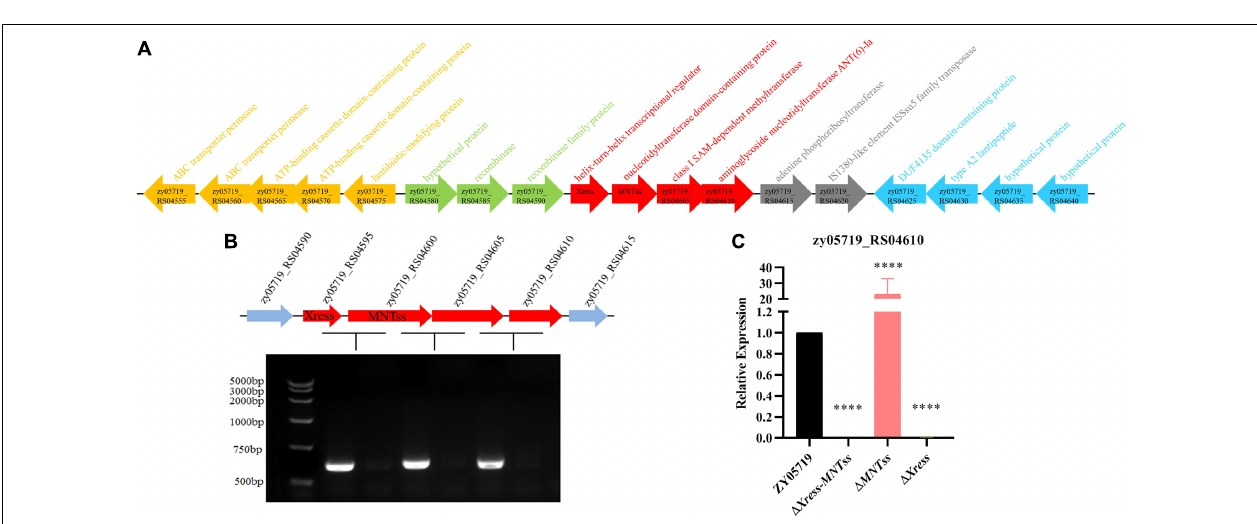
FIGURE 3 | EMSA analysis in vitro . (A) Purification of Xress-His protein from pColdTM II-Xress-containing BL21(DE3) E. coli . (B) Purification of Xress-MNTss-His protein from pColdTM II-Xress-MNTss containing BL21(DE3) E. coli . (C) EMSA result showing binding of the antitoxin Xress to the Xress-MNTss promoter. The purified Xress protein was added to each reaction mixture at different concentrations. DNA probes containing the Xress-MNTss operon promoter region were used at 80 ng per reaction mixture (lanes 1–5). And fragments amplified from 16S rRNA served as a negative control (lanes 6–7). (D) TA Xress-MNTss complex bound to the Xress-MNTss promoter. The Xress-MNTss promoter region could be shifted by the TA complex in EMSA. DNA probes containing the Xress-MNTss operon promoter region were used at 80 ng per reaction mixture (lanes 1–4). And fragments amplified from 16S rRNA served as a negative control (lanes 5–6).